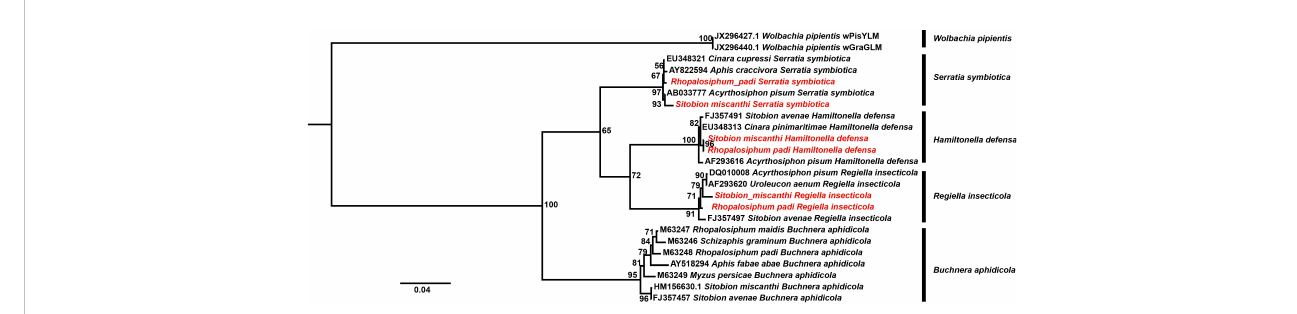
FIGURE 5 The phylogenetic analysis of aphid bacterial symbionts. The strains identi fi ed herein were highlighted with red.